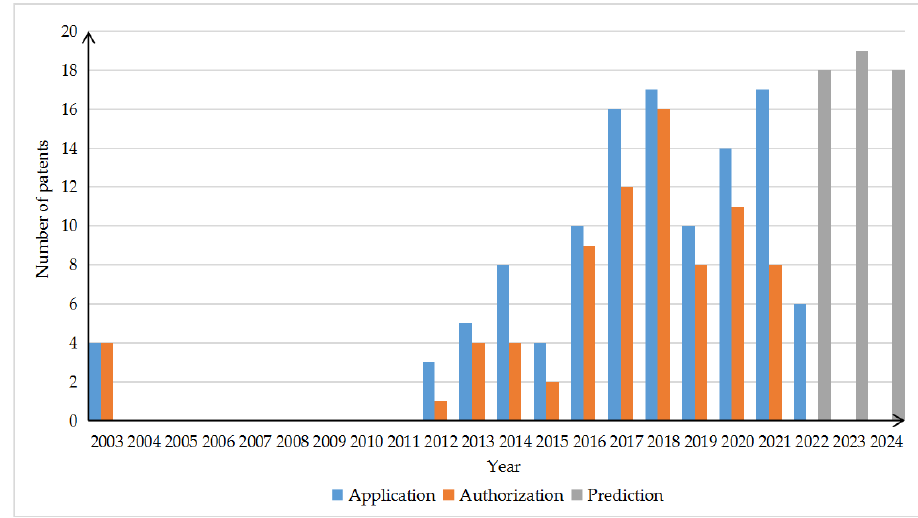
Figure 15. Drill pole tree-planting machine.